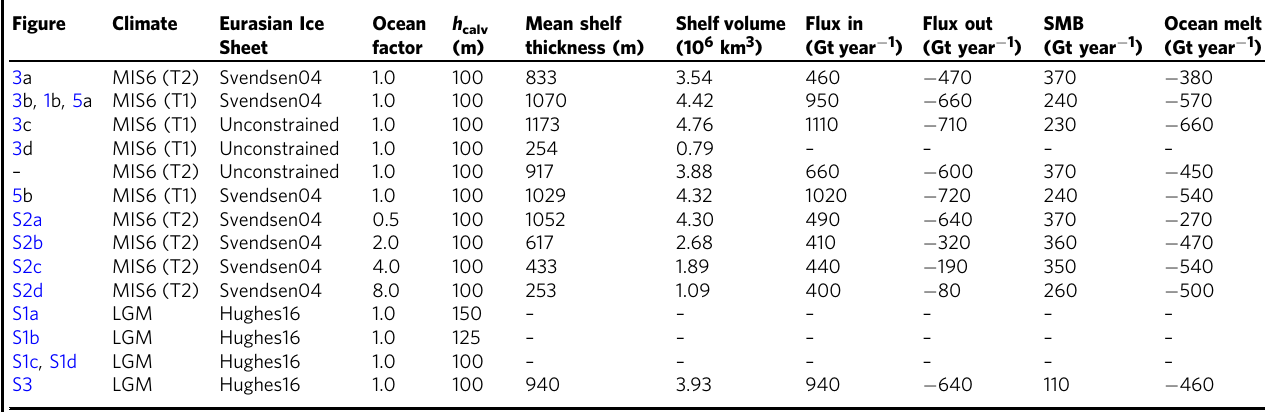
Table 2 Summary of experiments and Arctic ice shelf mass balance Figure Climate Eurasian Ice Sheet